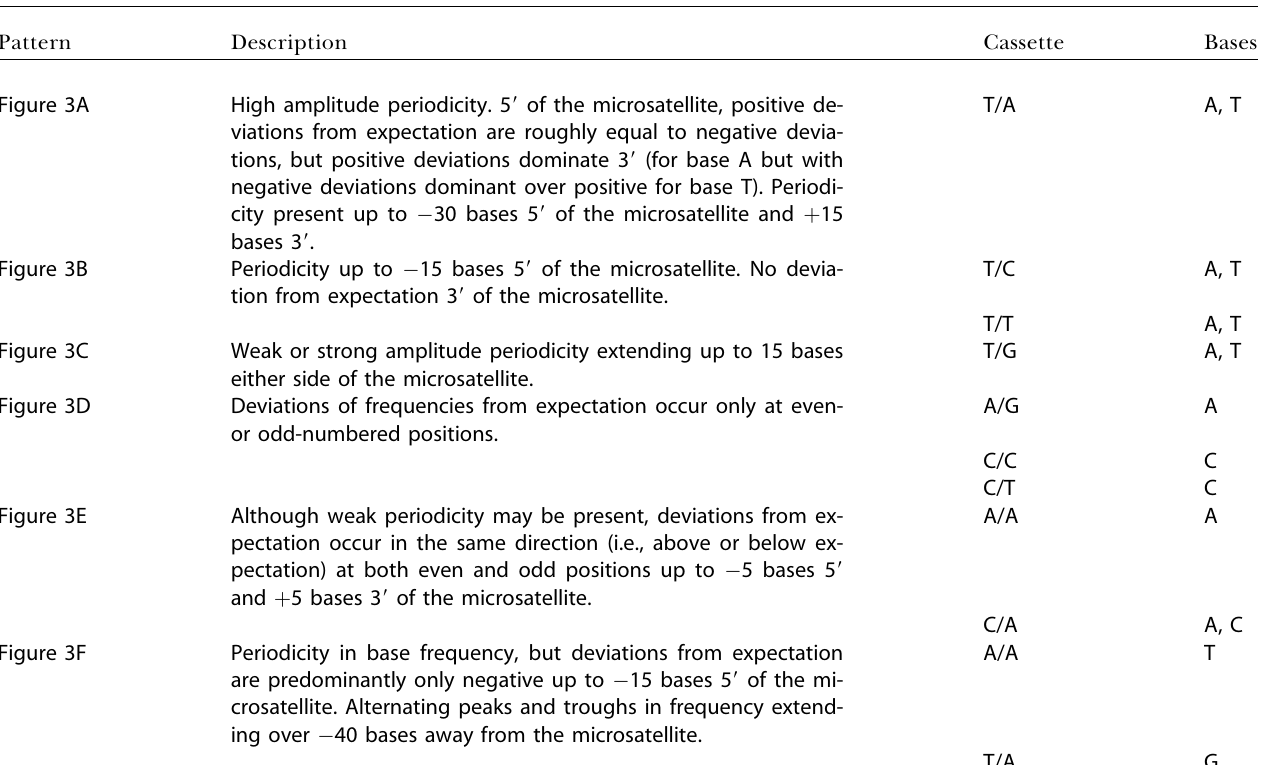
Table 1. Summary of Patterns in Flanking Sequence Base Frequencies by Cassette Pattern Description Figure 3A High amplitude periodicity. 5 9 of the microsatellite, positive de- viations from expectation are roughly equal to negative devia- tions, but positive deviations dominate 3 9 (for base A but with negative deviations dominant over positive for base T). Periodi- city present up to (cid:1) 30 bases 5 9 of the microsatellite and þ 15 bases 3 9 . Figure 3B Periodicity up to (cid:1) 15 bases 5 9 of the microsatellite. No devia- tion from expectation 3 9 of the microsatellite. Figure 3C Weak or strong amplitude periodicity extending up to 15 bases either side of the microsatellite. Figure 3D Deviations of frequencies from expectation occur only at even- or odd-numbered positions.